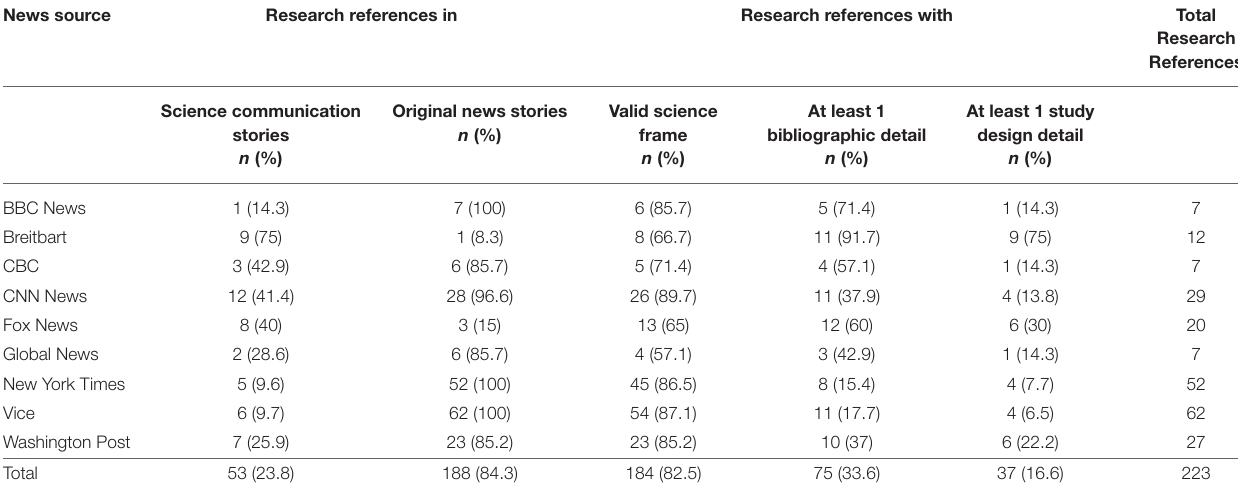
TABLE 3 | Research references by news source.